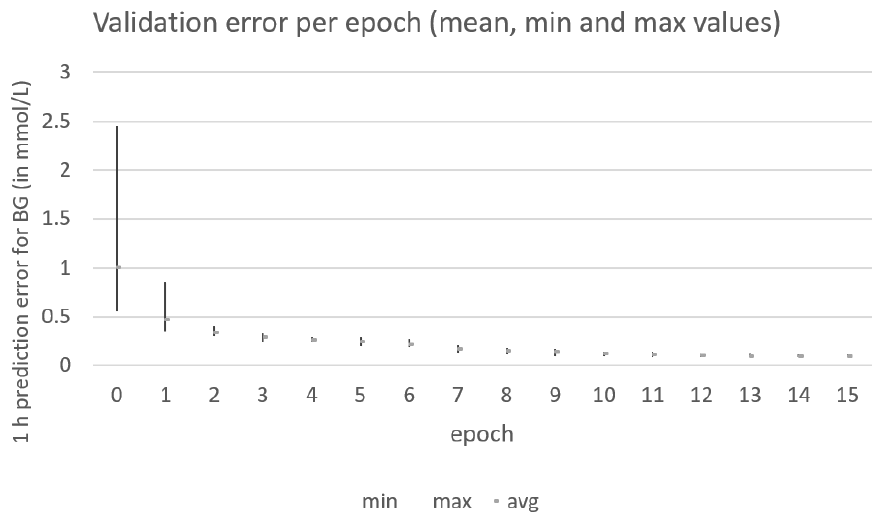
Figure 6. Mean, min, and max prediction errors for the individuals computed at each epoch by the genetic algorithm for one patient generated by the AIDA2 simulator.